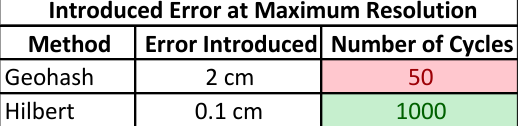
Table 4. Error Rate Introduction Comparison